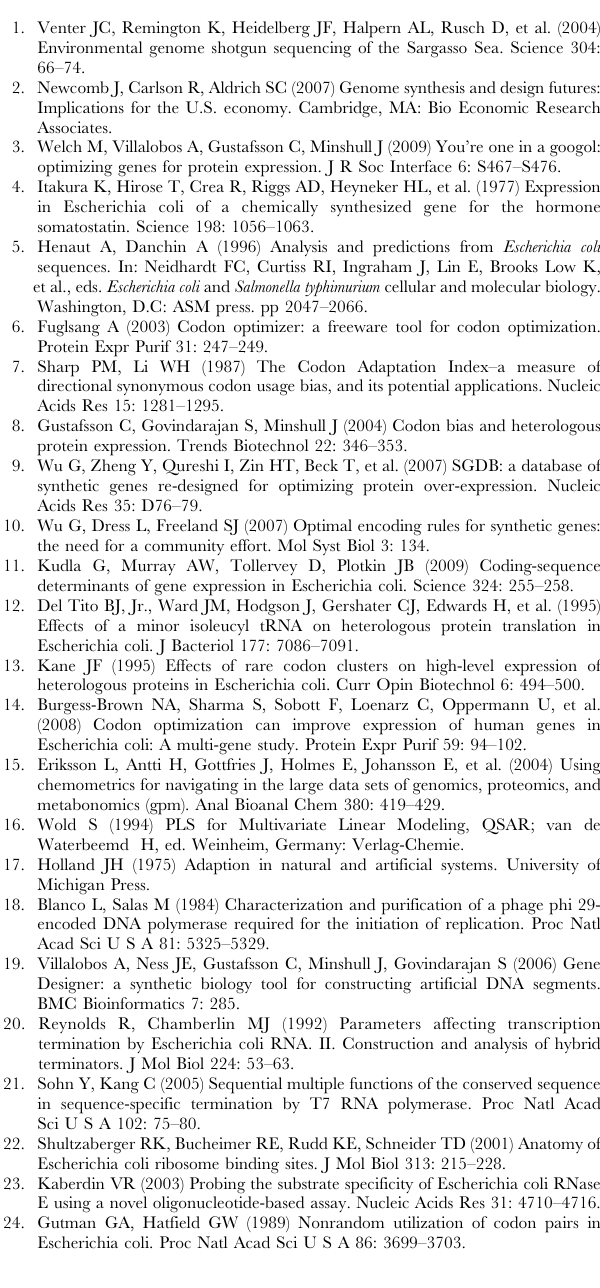
Table S3 PLS model statistics for combined gene sets Statistics for the PLS model depicted in Figures 2C, 5, & 6 of the manuscript. Codons listed are those selected by genetic algorithm to provide minimal error in cross-validation for prediction of the dataset (see Materials and Methods). The particular model includes 5 latent variables, which were determined to yield minimal error in cross-validation. Mathematical descriptions of model statistics have been published by Eriksson, et al [15]. Statistics shown apply to the datatset preprocessed as described in Materials and